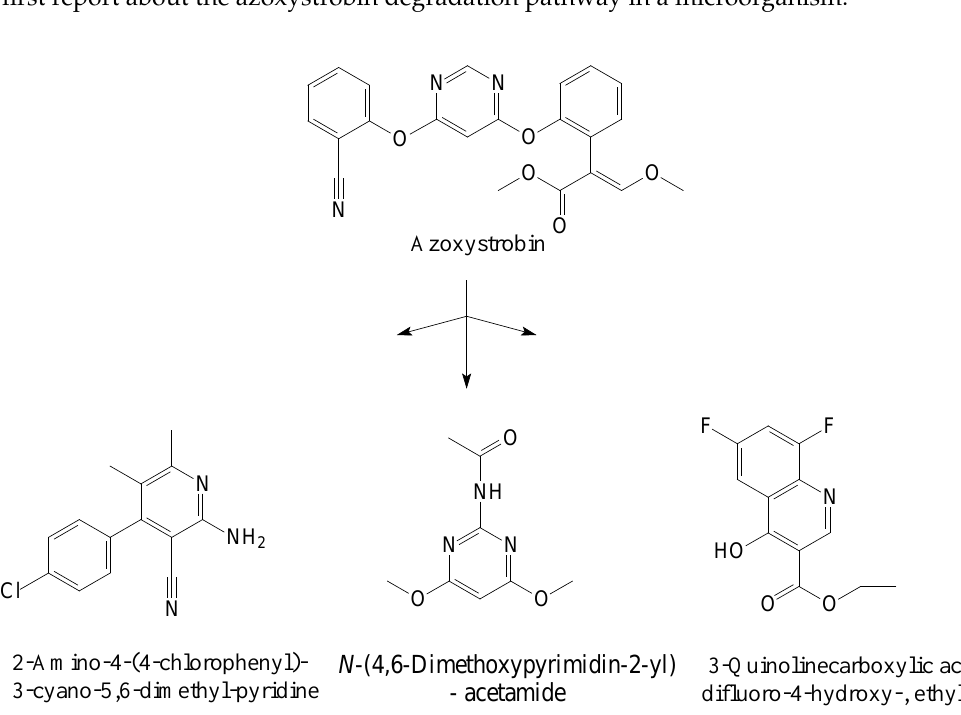
Figure 6. Proposed metabolic degradation pathway of azoxystrobin in strain SH14.